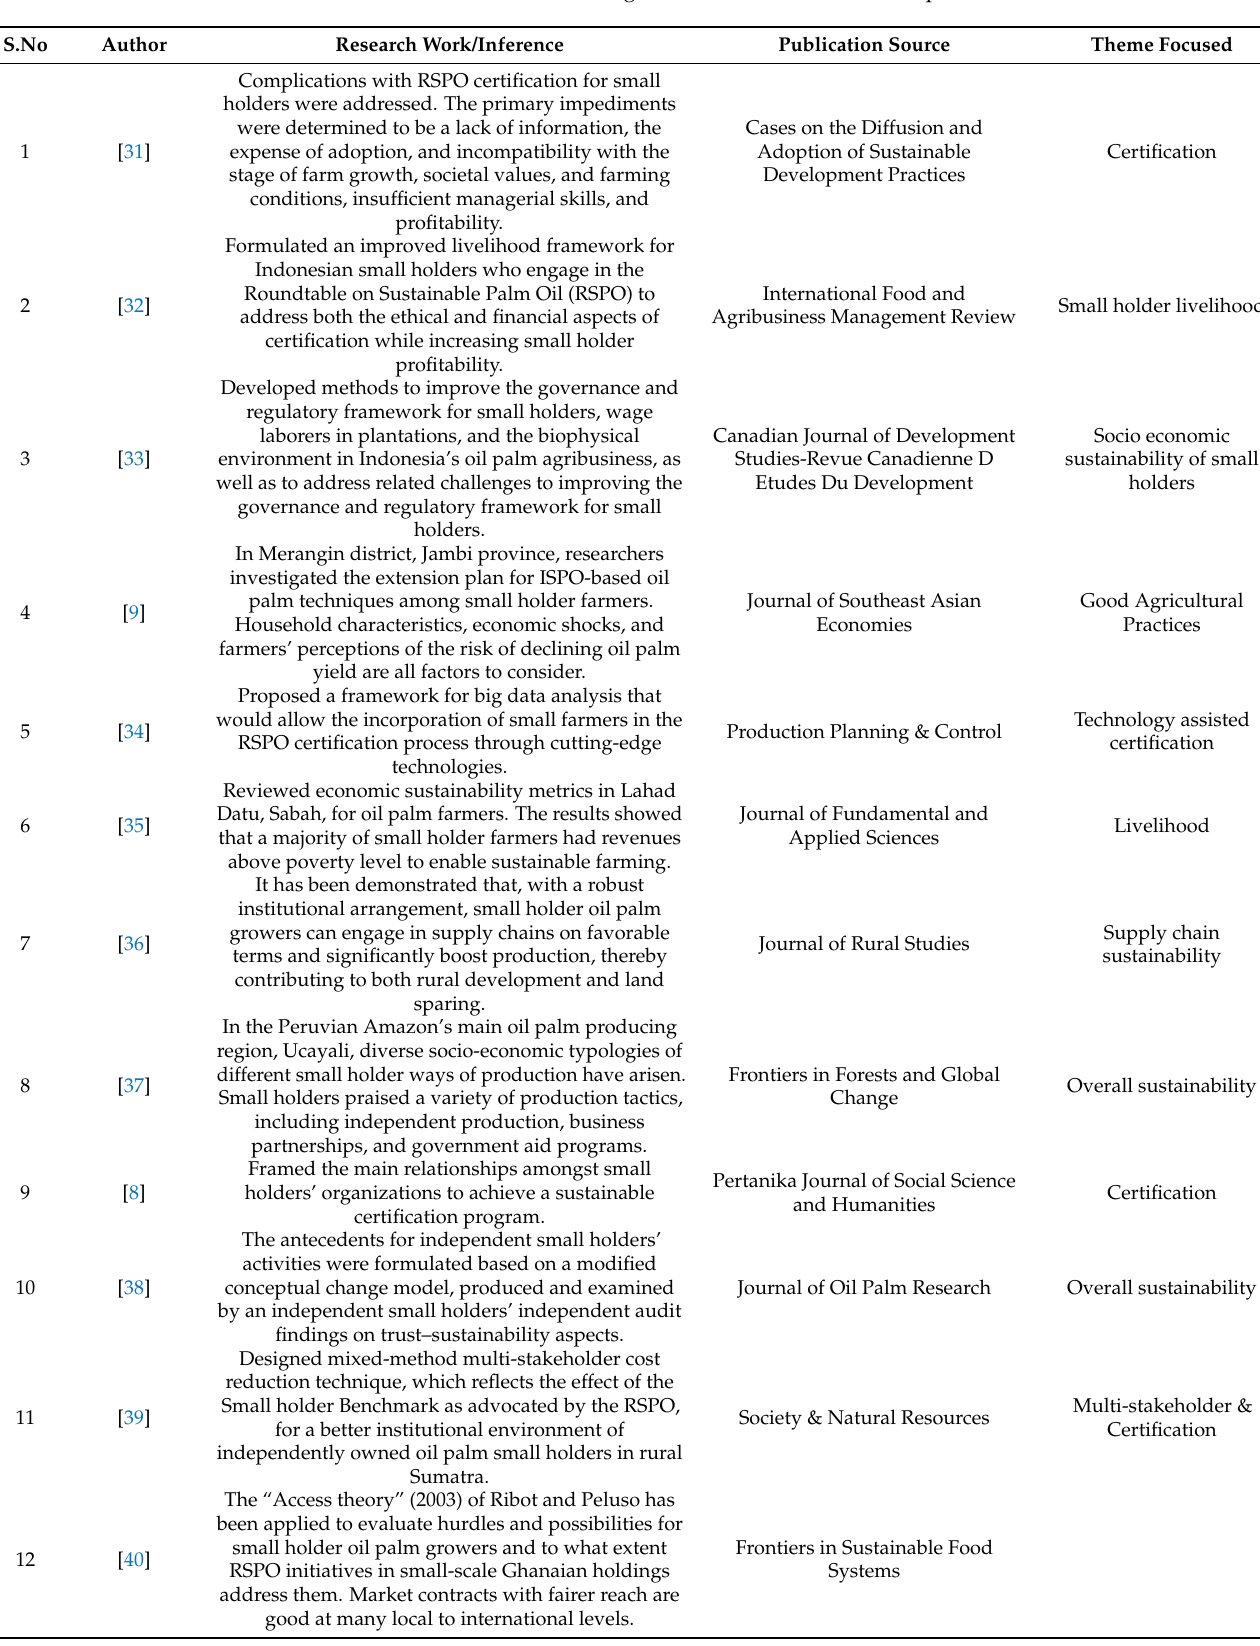
Table 1. List of research focusing on SHF vs. issue addressed/publication source/area